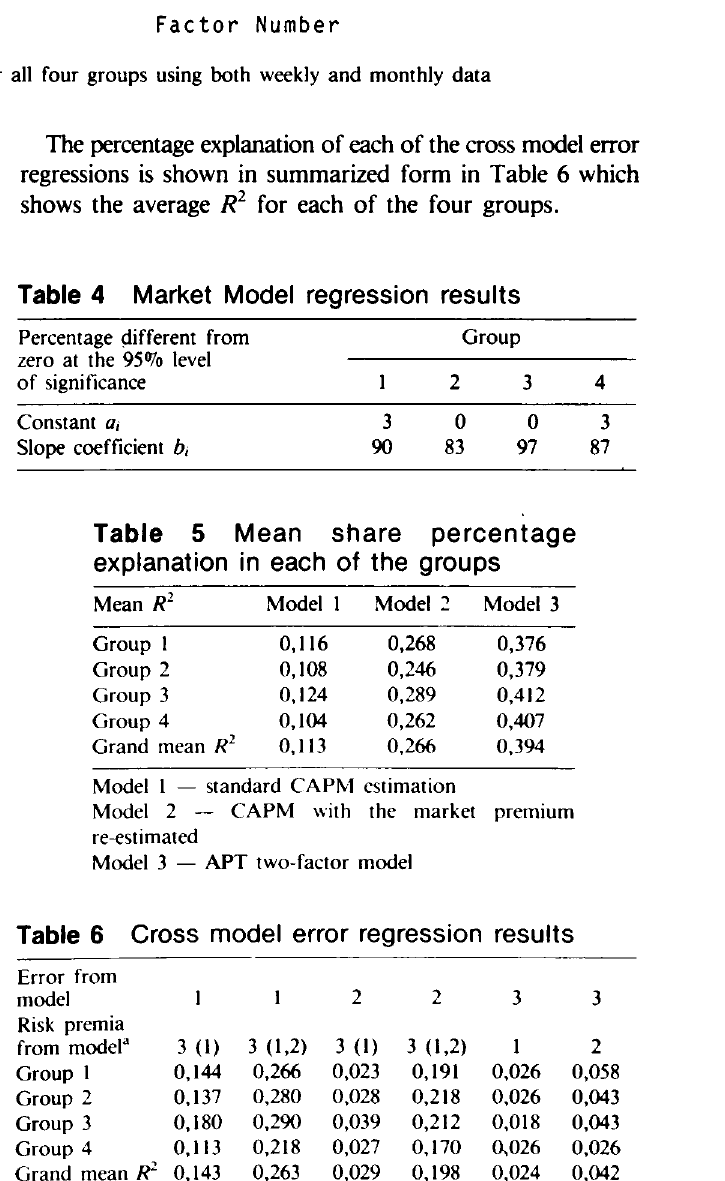
The percentage explanation of each of the cross model error